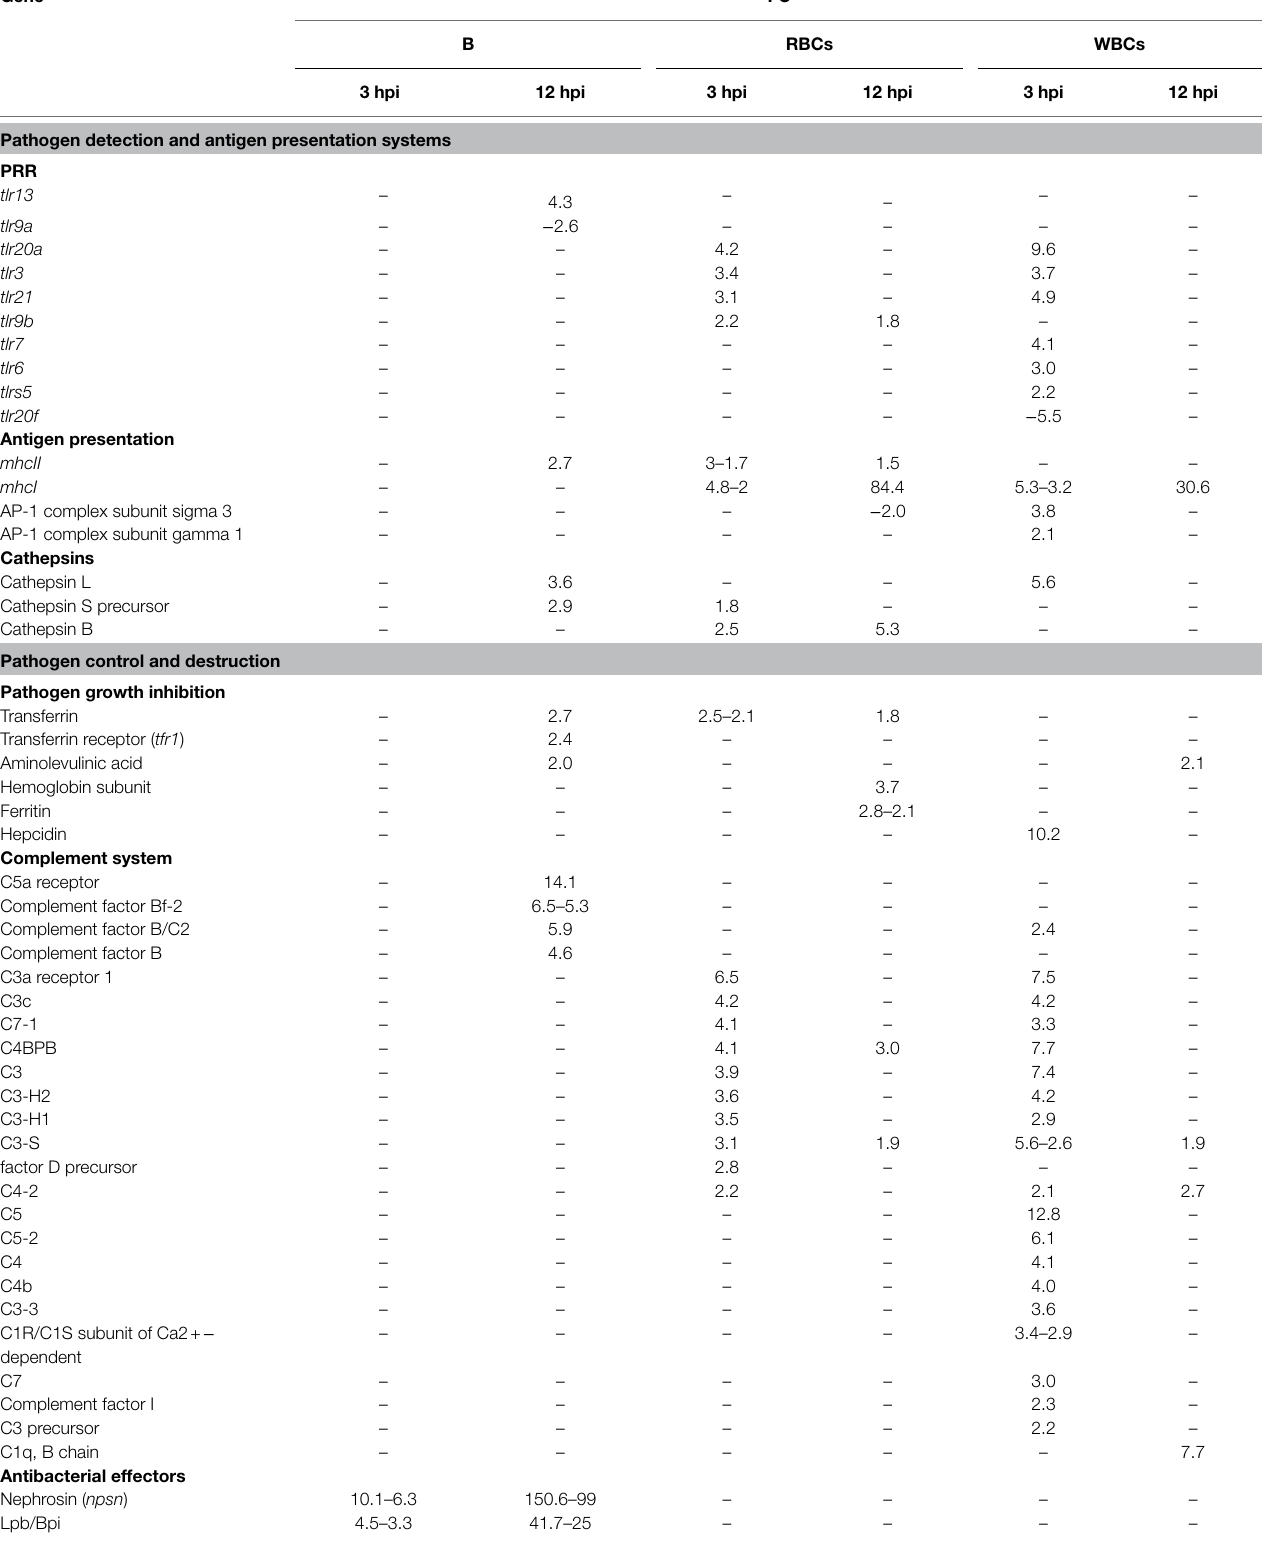
TABLE 2 | Eel blood transcriptome after V. vulnificus infection. Gene